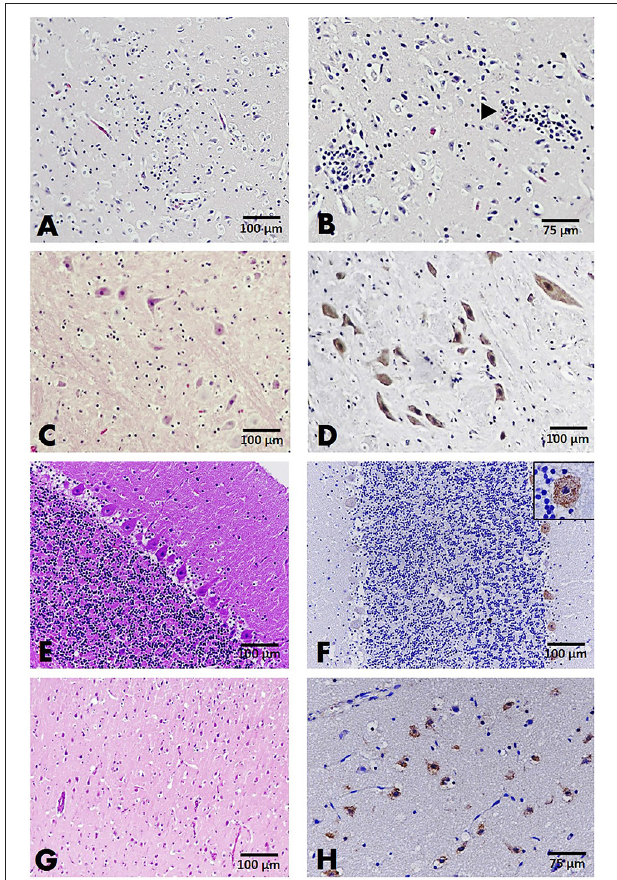
FIGURE 2 | Brain, cat (A–F) , and dog (G,H) . (A,B) The cerebral cortex of cat no. B32 presented gliosis (A) and two to three layers of perivascular cuffing (arrowhead) (B) , HandE staining. (C) Dark neurons were evident in the gray matter of the brain stem, HandE staining. (D) Immunoreactivity to parvovirus antigen in large neurons comprising the brain stem, IHC for parvovirus. (E) Section of the cerebellum showing no significant change (HandE staining), but demonstrating positive immunostaining to the parvovirus antigen in the cytoplasm of Purkinje cells (inset) composing the cerebellar cortex (F) . (G) Section of the cerebral cortex from a dog showing no significant changes in the resident cells, HandE staining. (H) . Parvovirus-antigen-positive staining was demonstrated in the small neurons comprising the cerebral cortex. IHC for parvovirus.